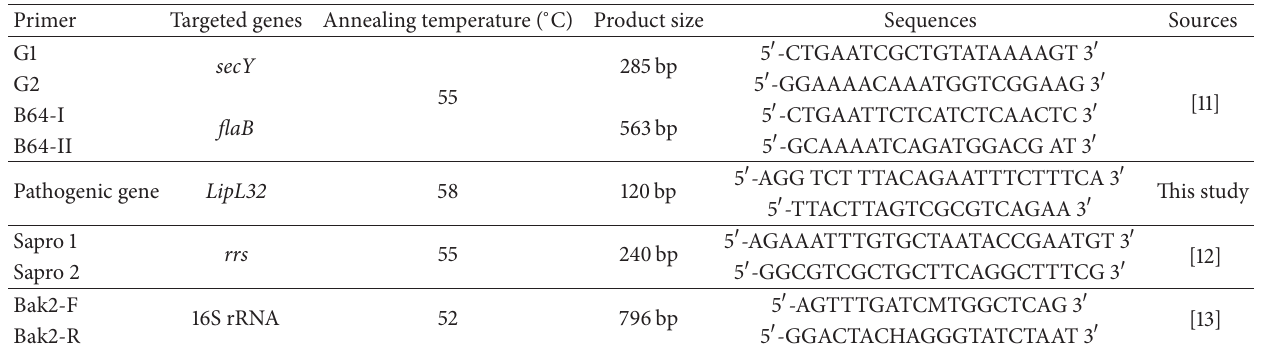
Table 1: List of primers